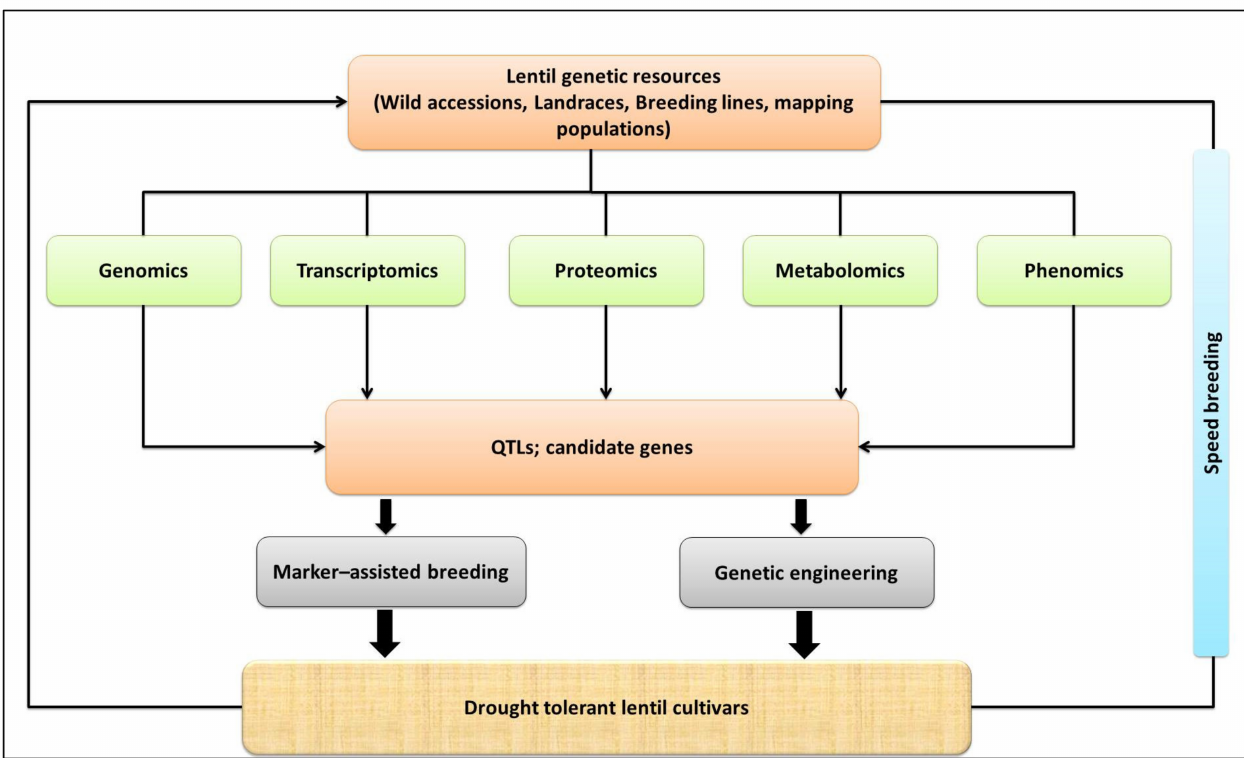
Figure 2. Overview of an integrated approach combining genetic resources, omics tools, genetic engineering, marker-assisted breeding, and speed breeding. Lentil genetic resources can be assessed for drought tolerance using single or integrated omics for identifying QTLs and candidate genes controlling drought-adaptive traits, which could be improved using marker-assisted selection and ge- netic engineering approaches. Furthermore, all processes of traits improvement could be accelerated with speed breeding to fast-track lentil cultivar delivery. Cultivars developed will be in turn used as a genetic resource in other breeding